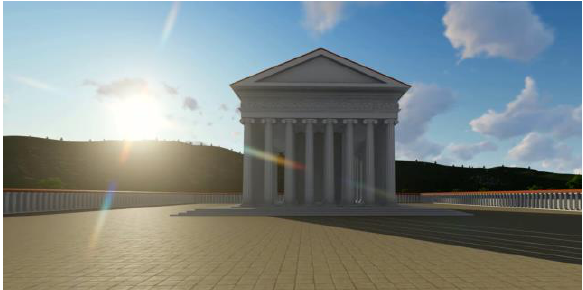
Figure 14. The Reconstruction of the Temple of Aphrodite at